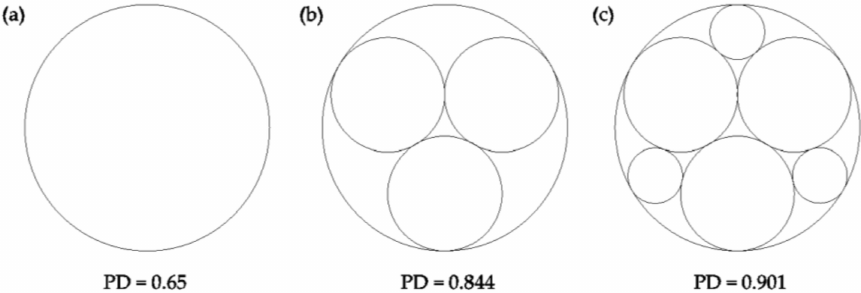
Figure 7. Diagram showing the three possible states of a pore in the proposed model, along with the packing density (PD) associated with each state: ( a ) unfilled pores, where packing density is similar to random close packing density; ( b ) partial pore filling state where three particles fill the pore; ( c ) maximal pore filling state where six particles fill the